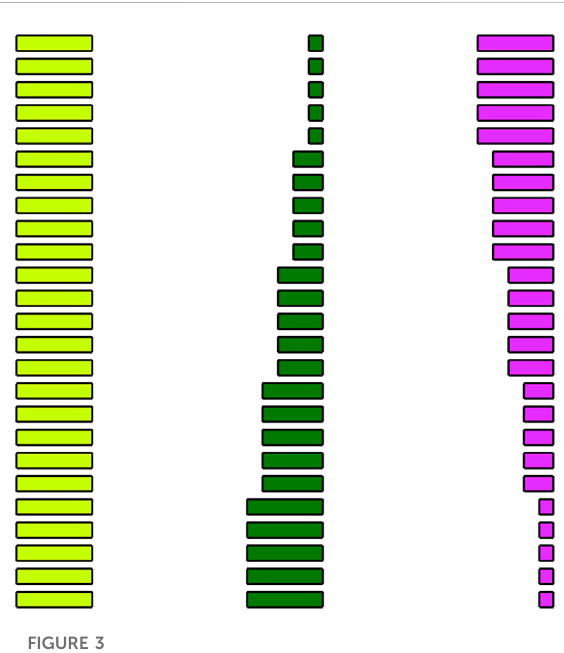
Structures of the solenoid magnets consisting of pancake windings with a rectangular cross-section, with a trapezoidal cross-section, and with an inverted trapezoidal